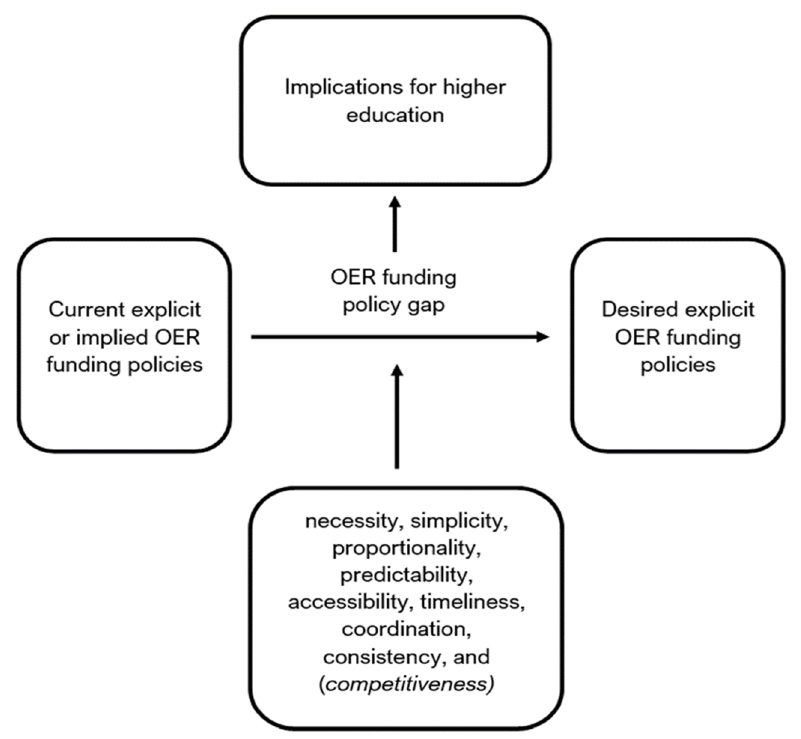
Figure 1. Conceptual framework (researchers). Source: researcher’s own construction (2022).